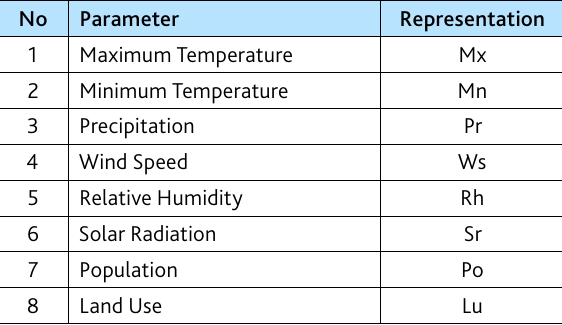
Figure 2. Fundamental of Kalman